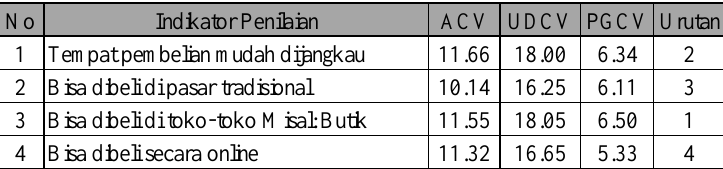
Tabel 4. Nilai indeks PGCV variabel